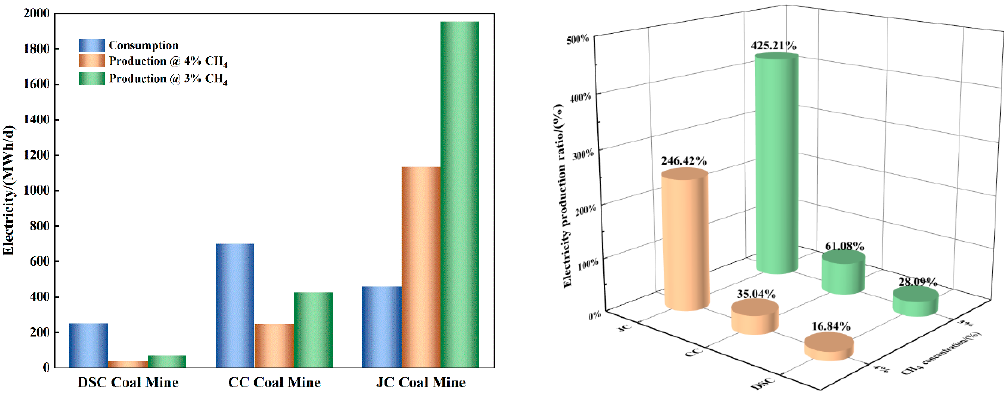
Figure 8. The quantity of electricity energy production from the co-production system in coal mines.